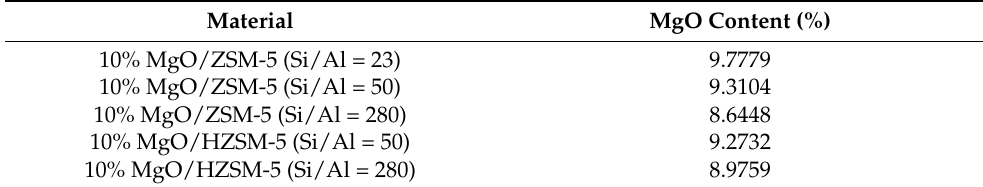
Table 2. The content of MgO in the investigated calcined catalytic